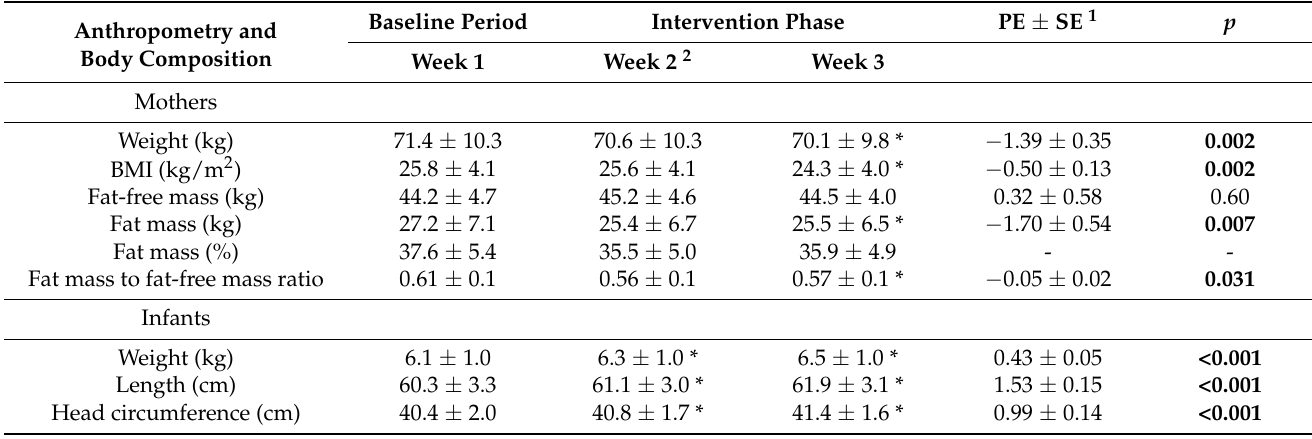
Table 5. Maternal body composition and infant growth measurements across the study 1